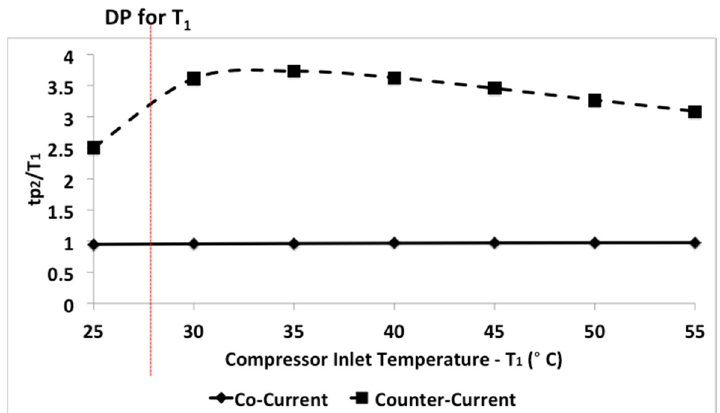
Figure 9. Heat Sink Outlet Temperature for IC. The heat sink outlet temperature is normalised by the respective cycle/compressor inlet temperatures.